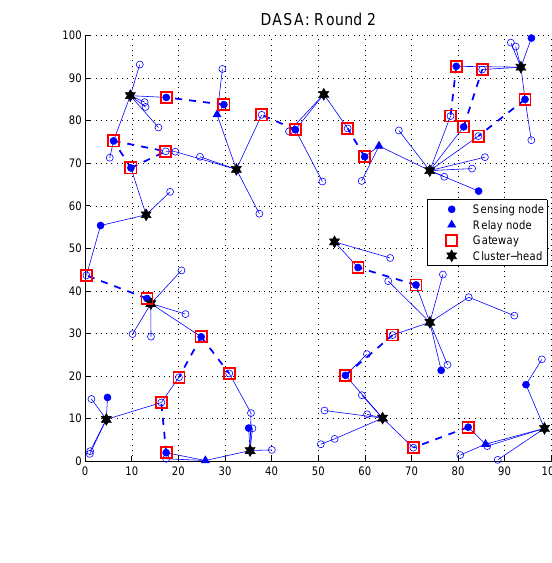
Figure 22. The network connectivity using the DASA scheme in round 1 (left) and round 2 (right).